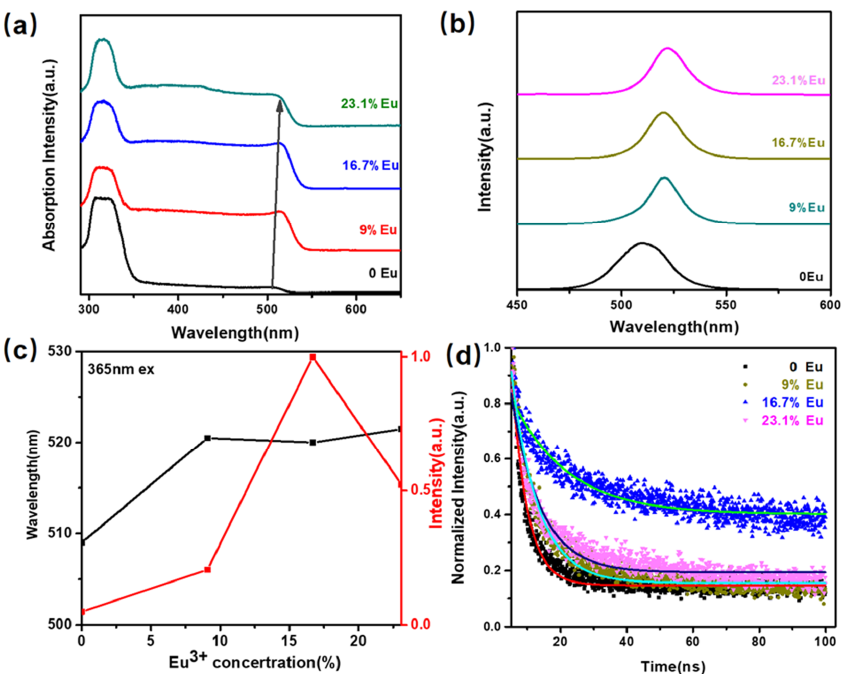
Figure 4. CsPbBr 3 /Cs 4 PbBr 6 :Eu 3+ composites with different Eu 3+ doping concentrations: ( a ) absorp- tion spectra, ( b ) PL spectra, ( c ) PL peak position and intensities, and ( d ) PL decay curves.